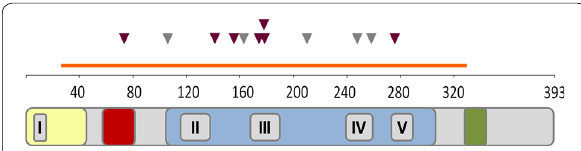
Fig. 1 Localization of the mutations detected on the p53 gene. The sequenced region is indicated with an orange line in the figure above. Mutation locations are indicated with arrowheads ( purple mutations found in angiogenic samples; gray : mutations found in non‑angiogenic samples). Human P53 protein (HP53) can be divided into five domains, each corresponding to specific functions: yellow is the highly conserved domain I (HCD I)/transactivation domain; red is the second transactivation domain, which is proline‑rich; blue is the DNA‑binding domain essential for p53 ‑DNA interactions that also contains HCD II‑V and is the target of 90% of the p53 mutations found in human cancers; green is the nuclear export signal (NES) localized